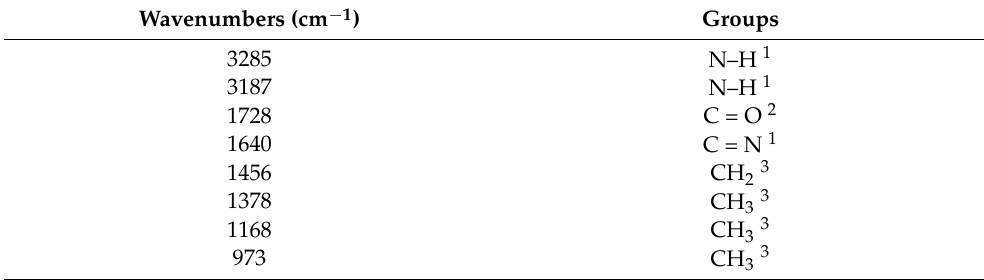
Figure 1. FTIR spectra of PP and PP − g − PHMG/PP − blended monofilaments. Table 1. Wavenumbers and assigned groups of PP − g − PHMG/PP mono fi laments.